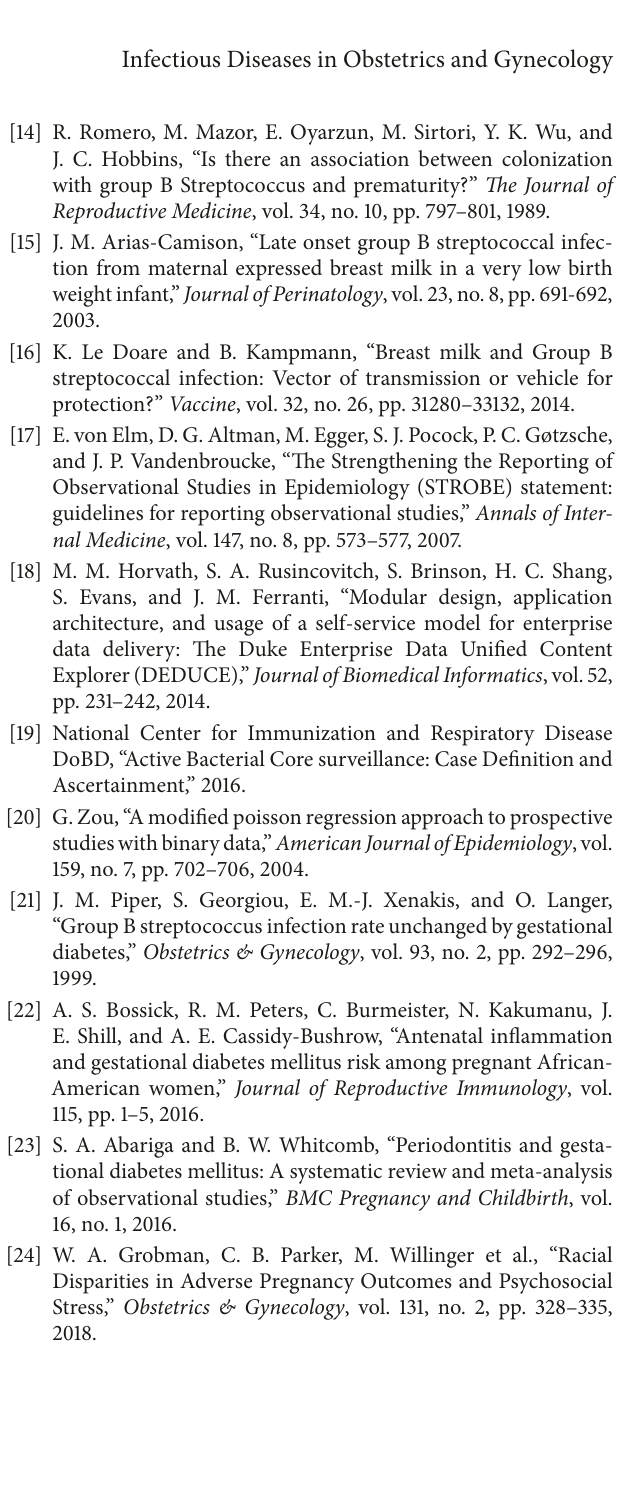
Supplemental Table 1 : ICD-9 and -10 codes for data abstrac- tion. (Supplementary